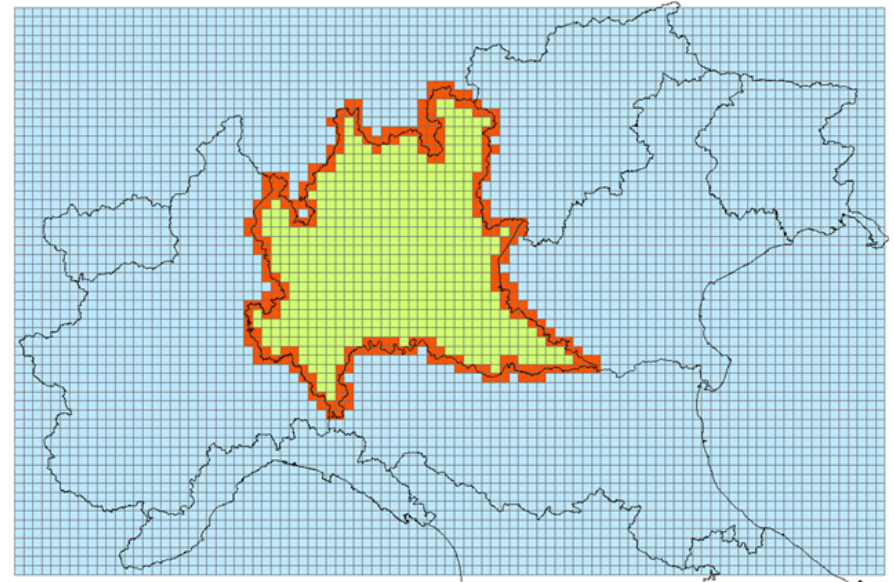
Figure 2. The domain considered in the case